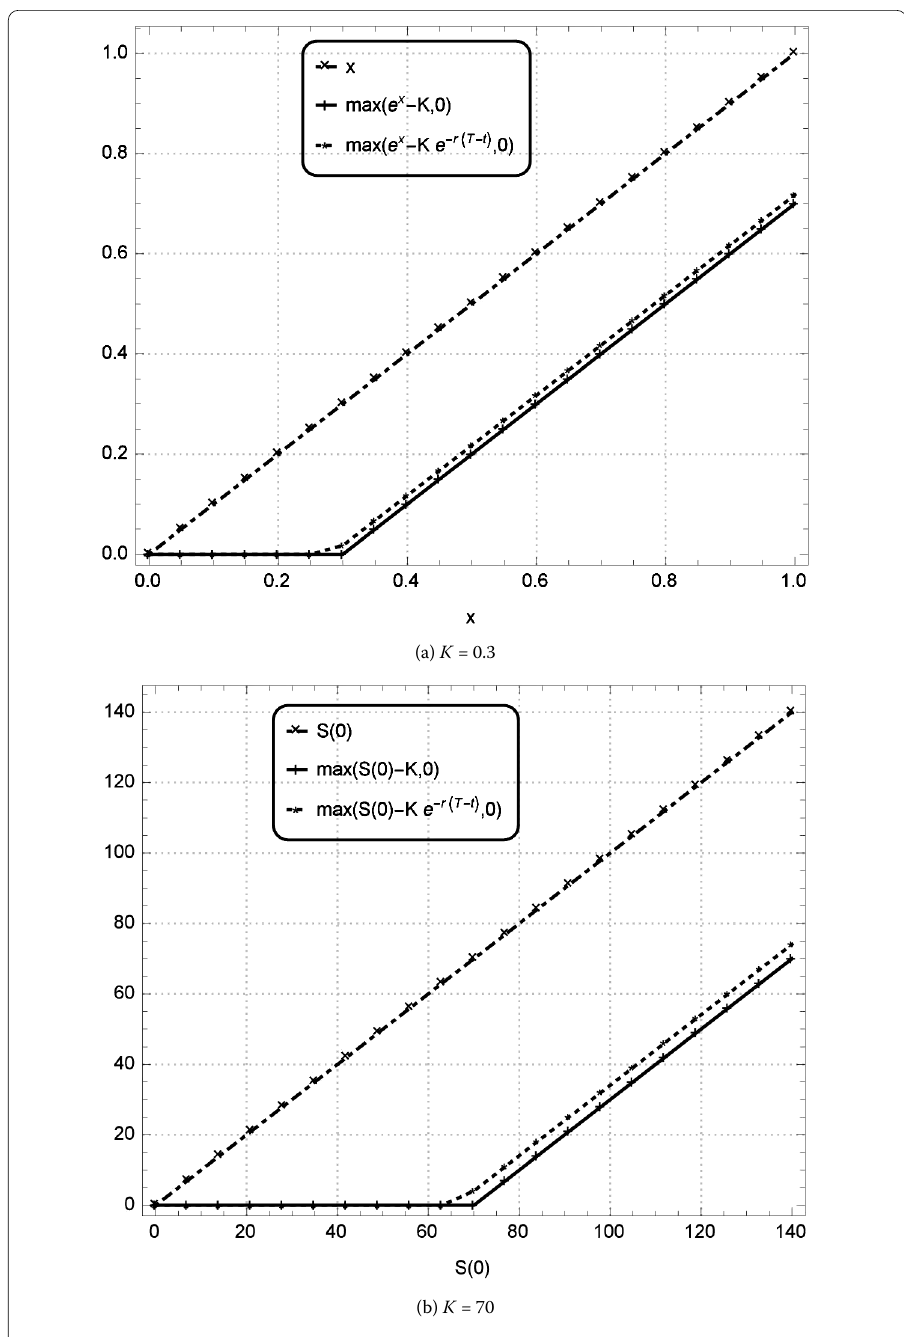
Figure 1 Price values of underlying